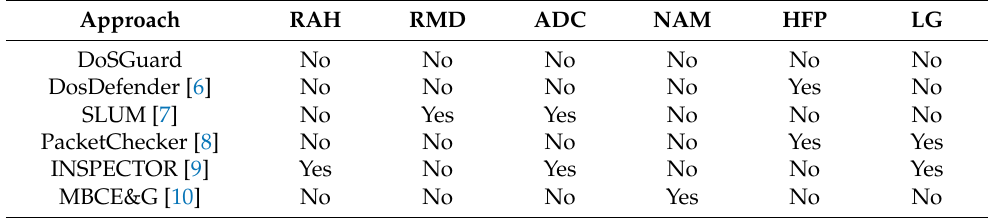
Table 1. Comparison with different approaches. Approach RAH